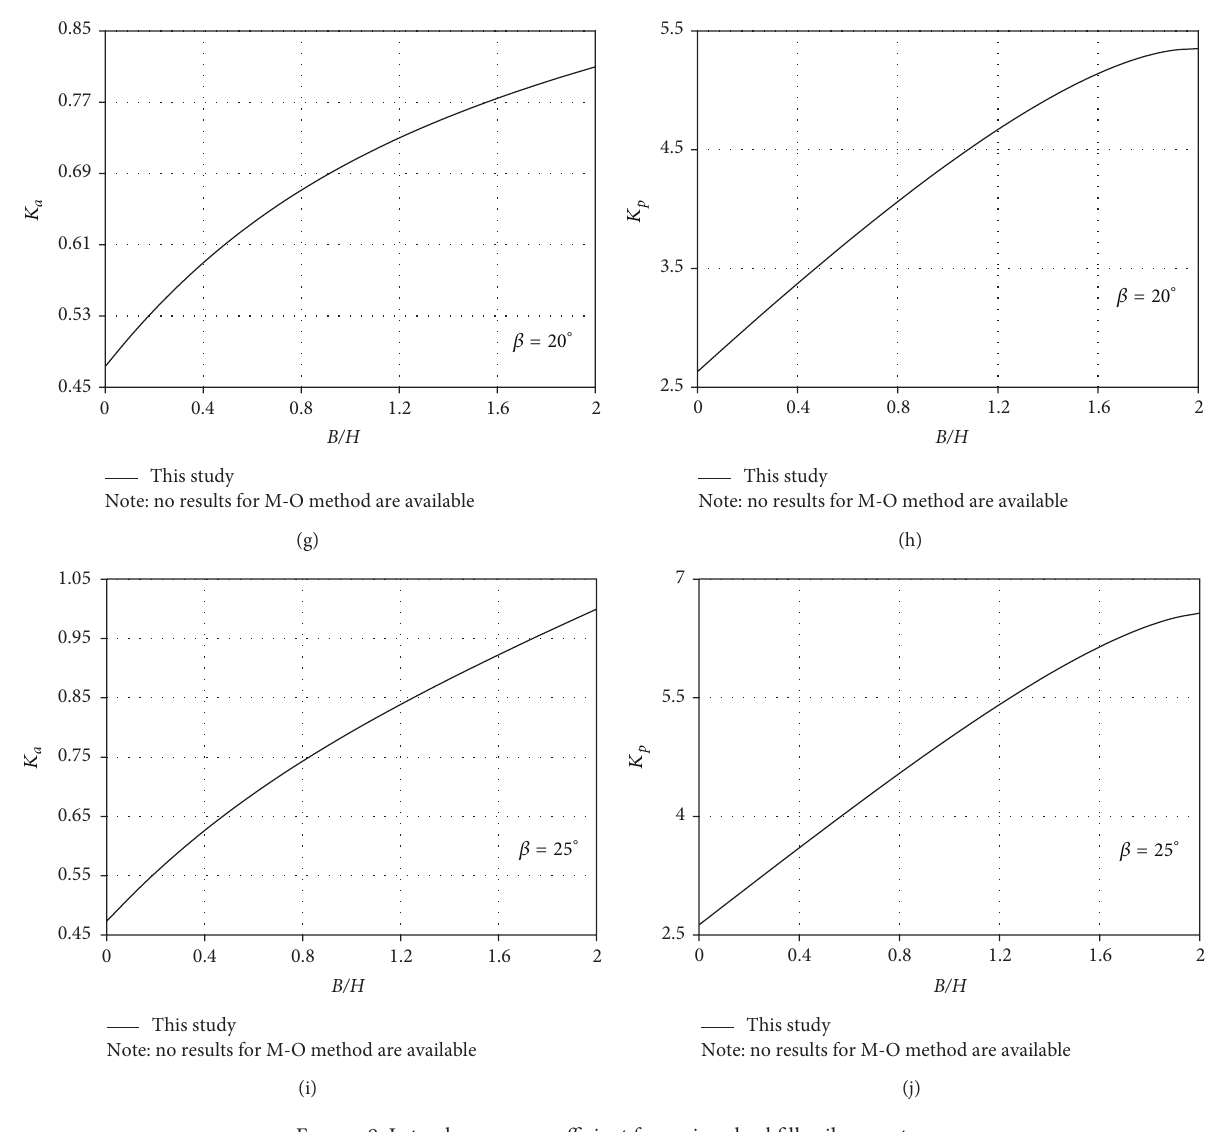
Figure 9: Lateral pressure coefficient for various backfill soil